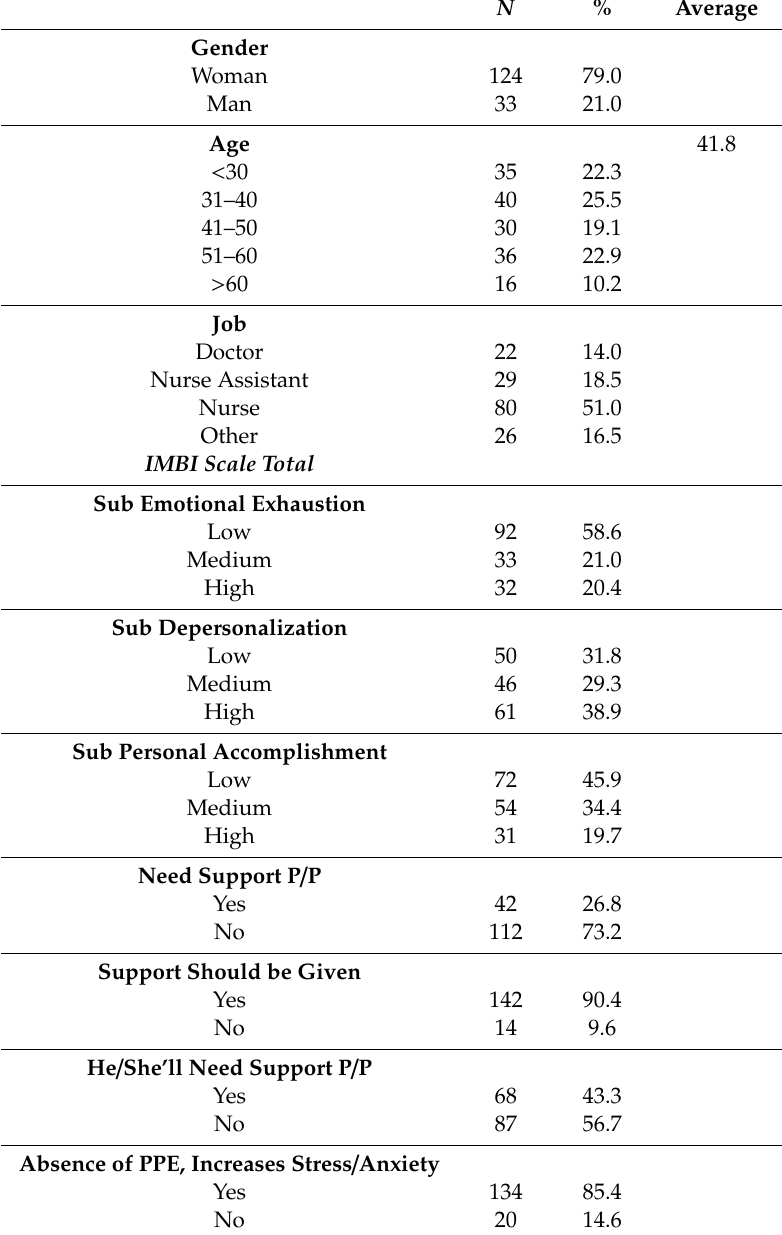
Table 1. Descriptive analysis of the